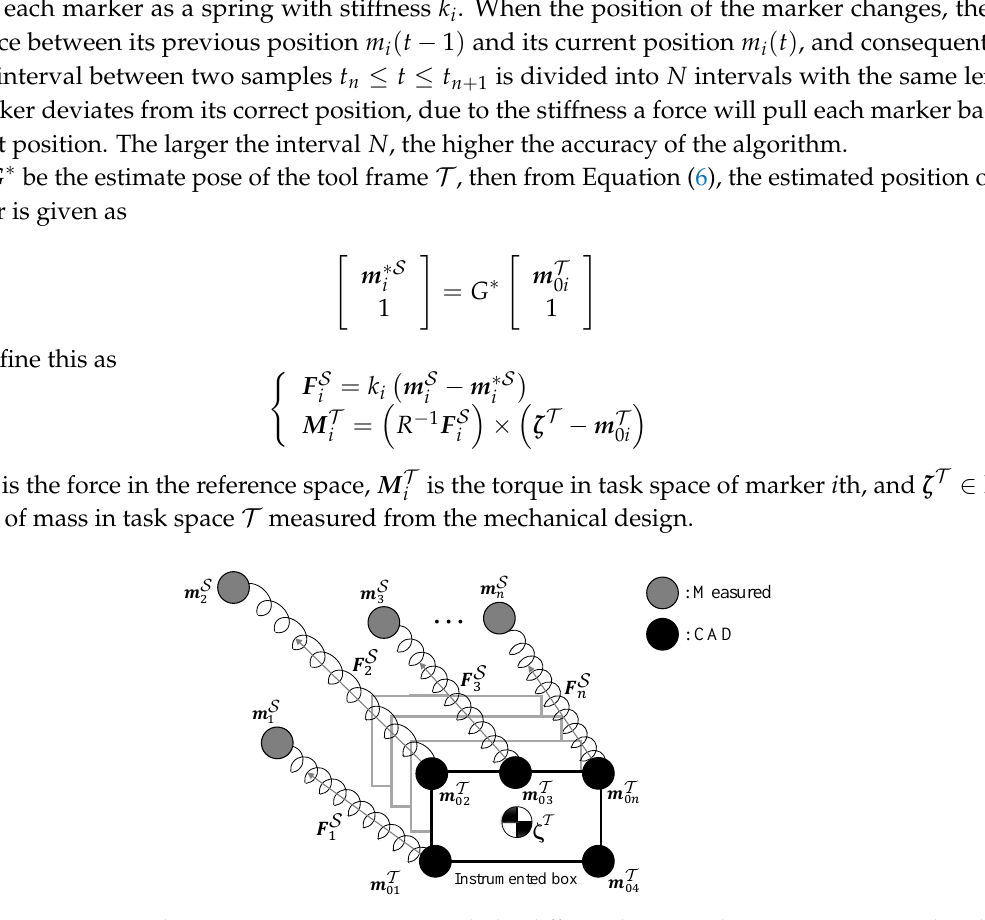
Figure 2. Spring-Markers system: In a time interval, the different between the position estimated and position from CAD of each marker cause the force pull the tool back to the right